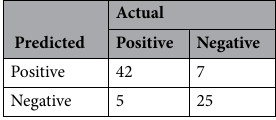
Table 1. Confusion matrix for the AI sonification majority vote.